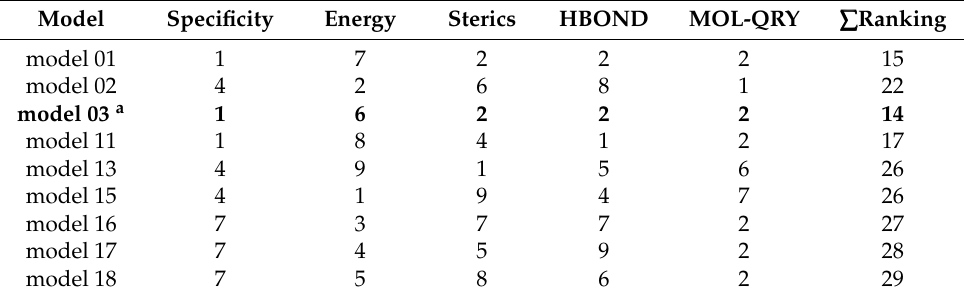
Table 2. The ranking results of orthosteric GALAHAD models of mGluR I.